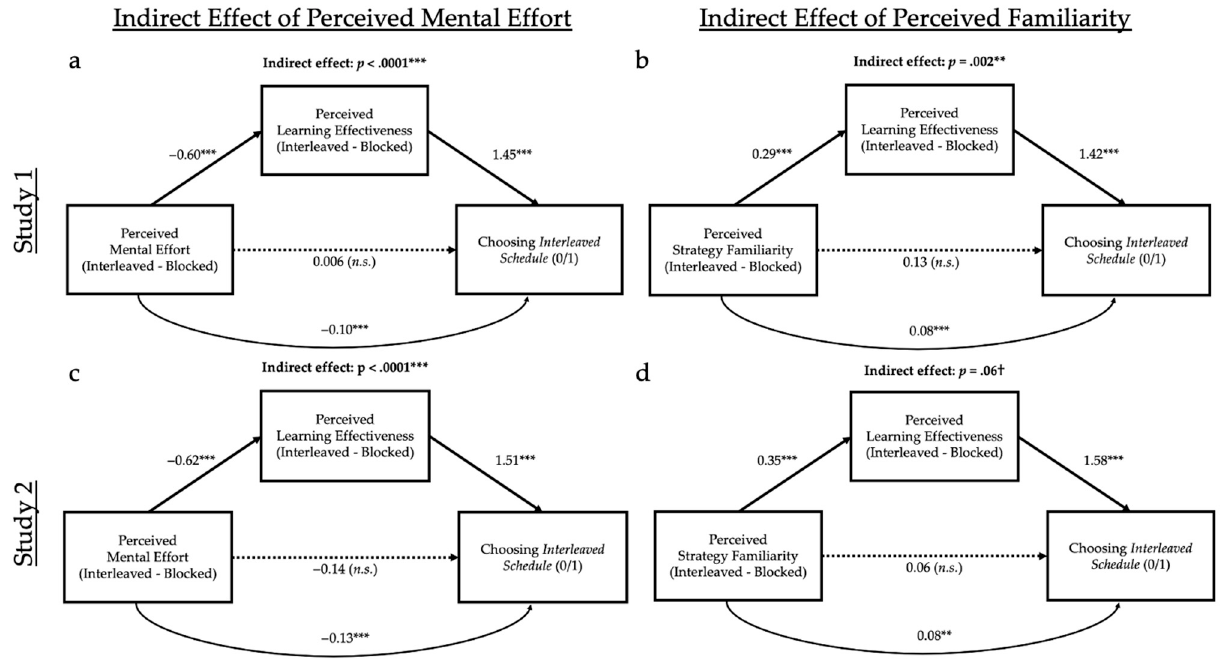
Figure 4. Bootstrapped mediation analyses for Study 1 for the unstandardized effects of mental effort ( a ) and familiarity ( b ) using the immediate-perception measures; bootstrapped mediation analyses for Study 2 for the unstandardized effects of mental effort ( c ) and familiarity ( d ) using the immediate-perception measures. † < .10, ** p < .01, *** p <